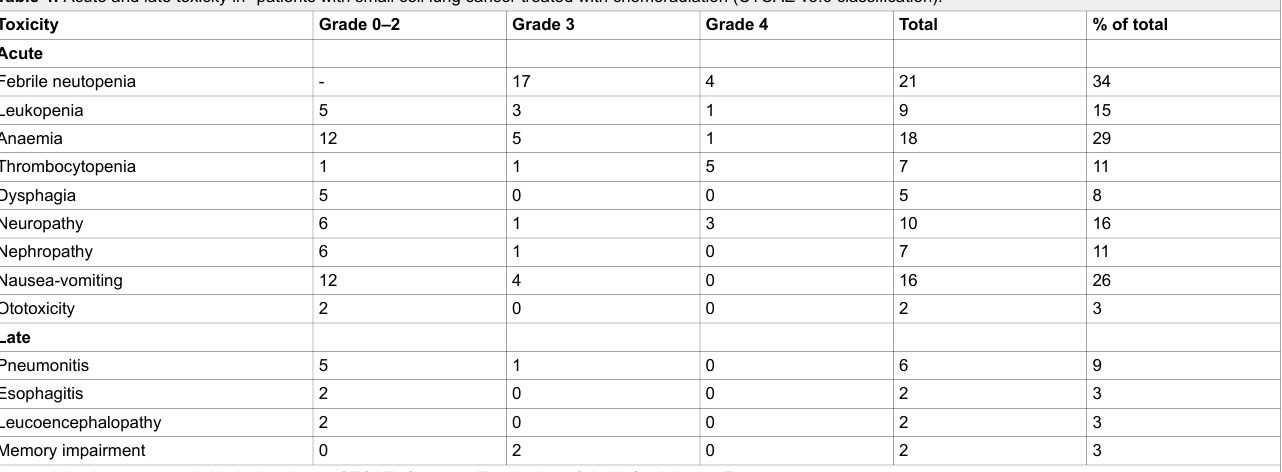
Table 4: Acute and late toxicity in *patients with small cell lung cancer treated with chemoradiation (CTCAE v3.0 classification).